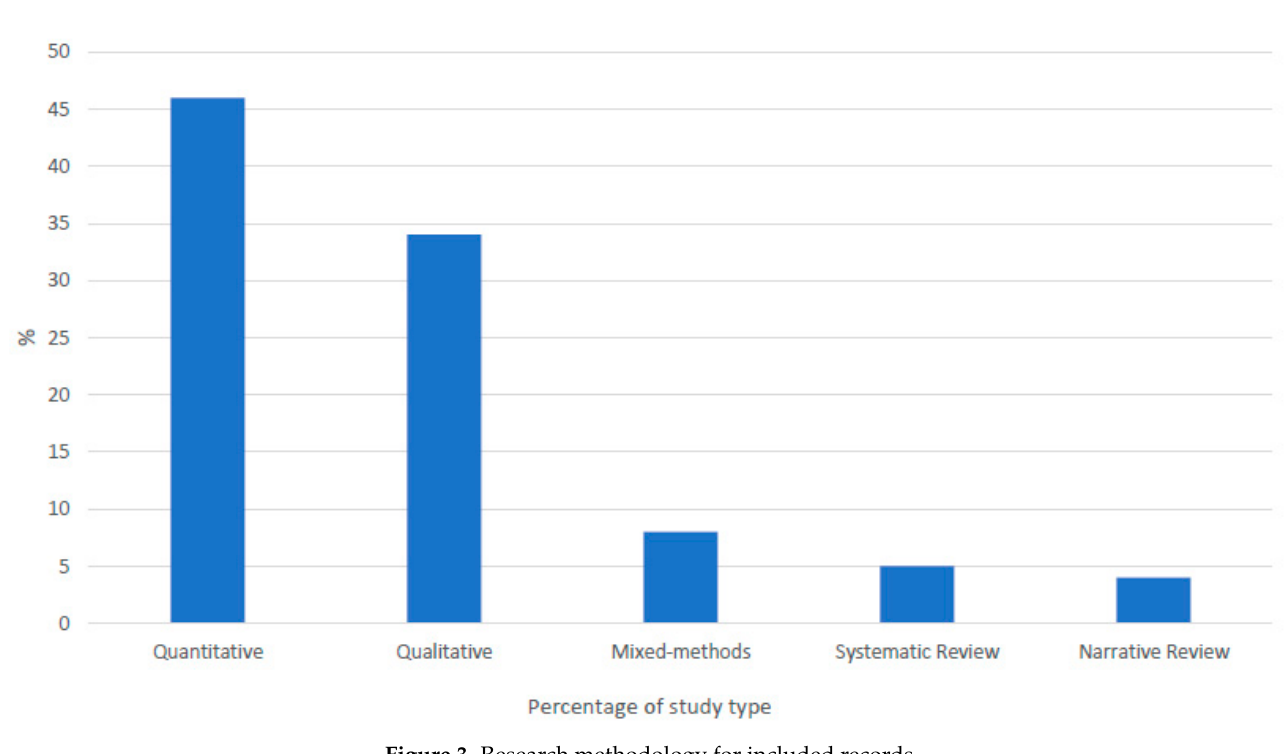
Figure 3. Research methodology for included records.